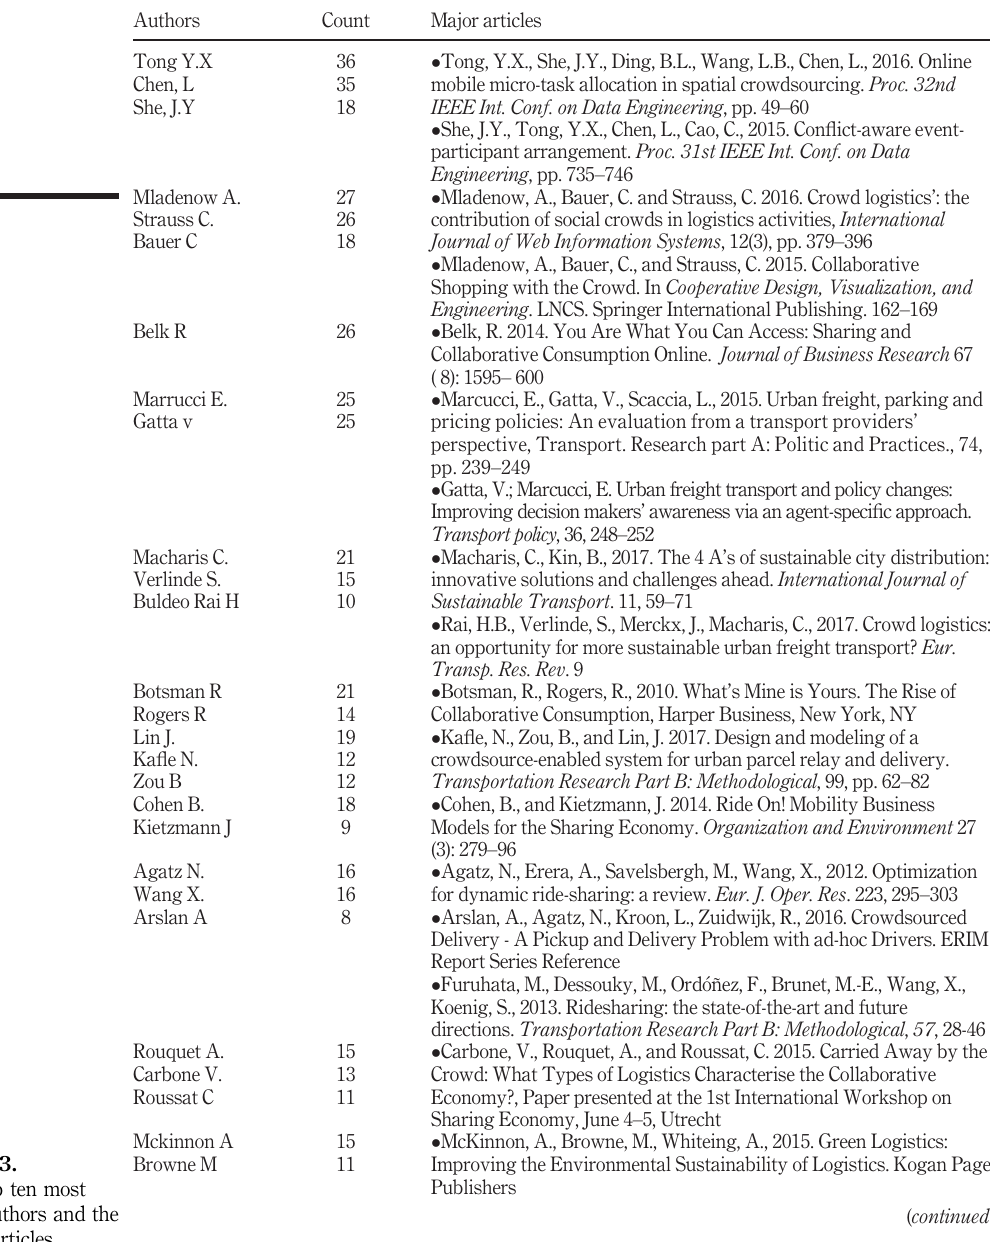
Table 3. The top ten most cited authors and the major